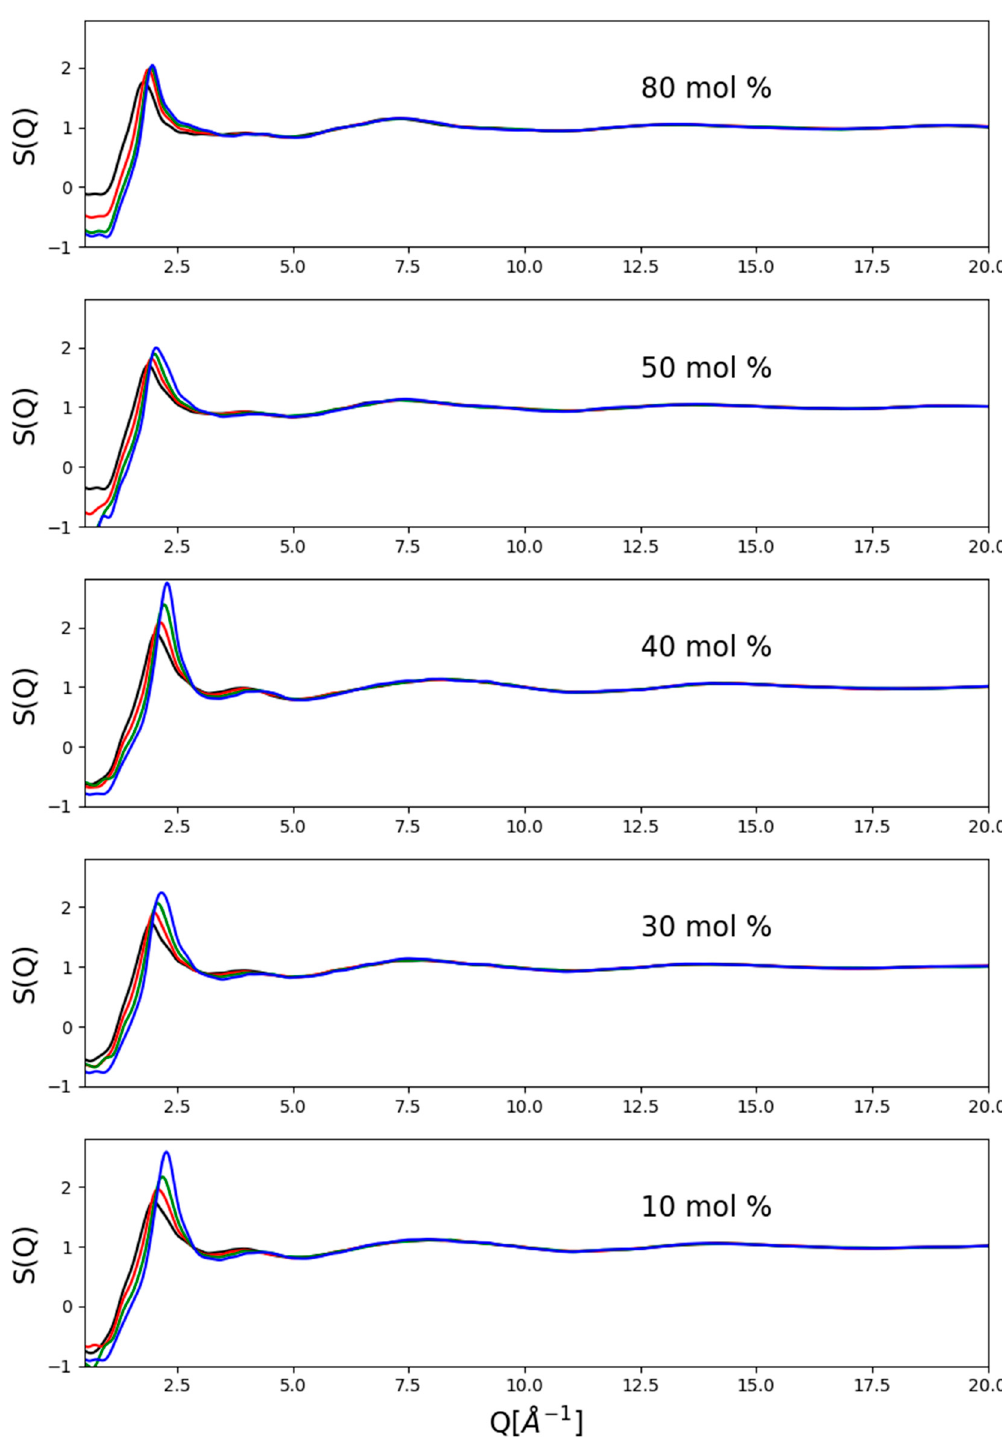
Figure 1. Measured total scattering structure factors of selected methanol–water mixtures at room temperature as a function of pressure between 0.15 and 1.2 GPa. Note that pressure-induced changes were more apparent at lower methanol concentrations (below x Me = ca. 0.5). Black lines: 0.15 GPa; red: 0.4 GPa; green: 0.8 GPa; blue: 1.2 GPa.